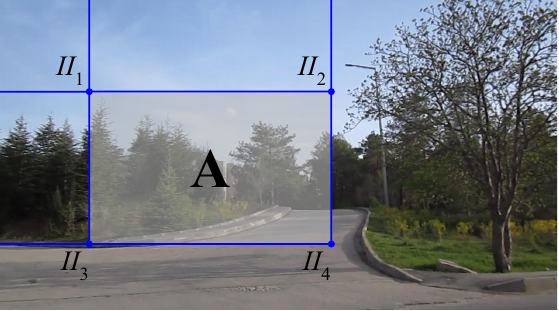
Figure 2. The method of integral images for the efficient computation of sums of intensities